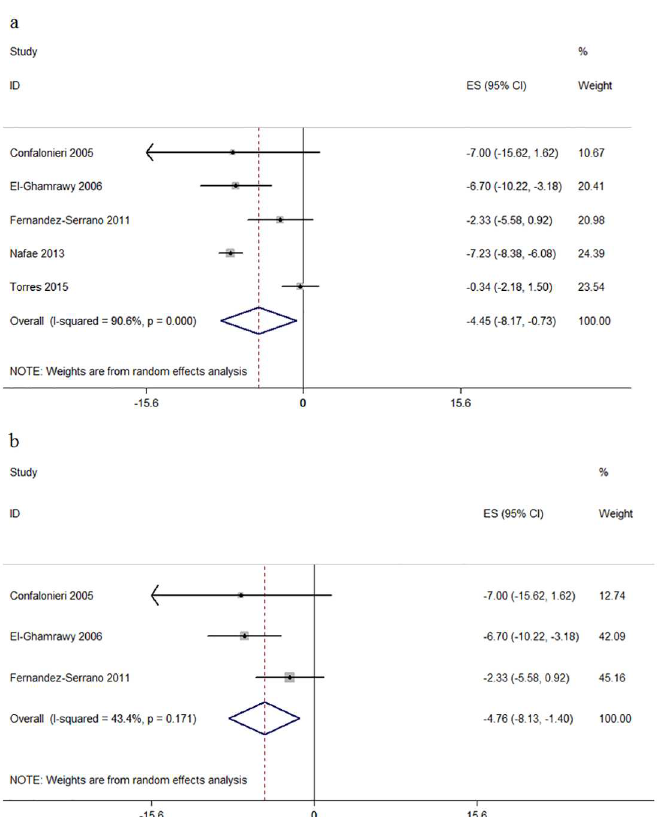
Fig 4. Forest plots of the association between length of hospital stay and